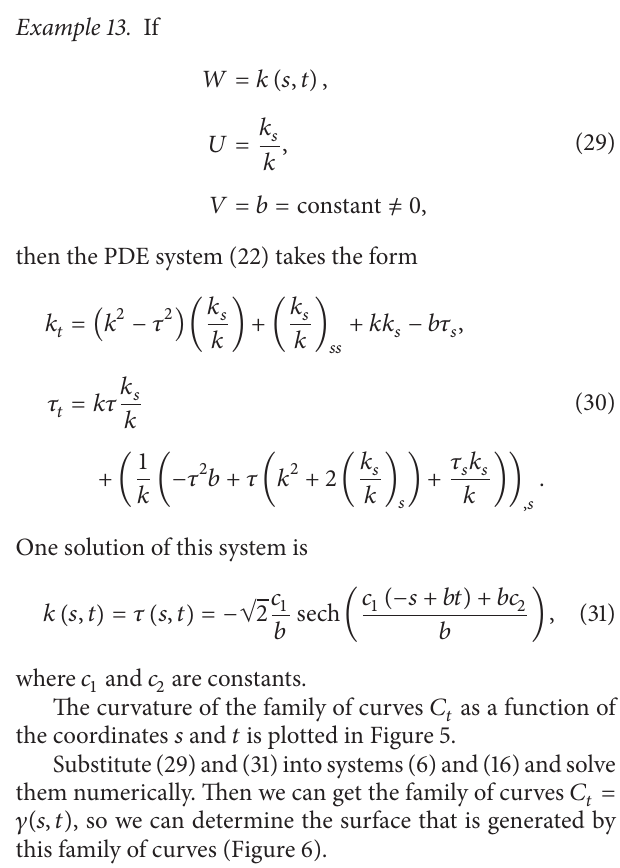
= 1 , 𝑐 = 0.01 , 𝑐 = 0 , and 𝑐 = 1 . 1 2 3 4